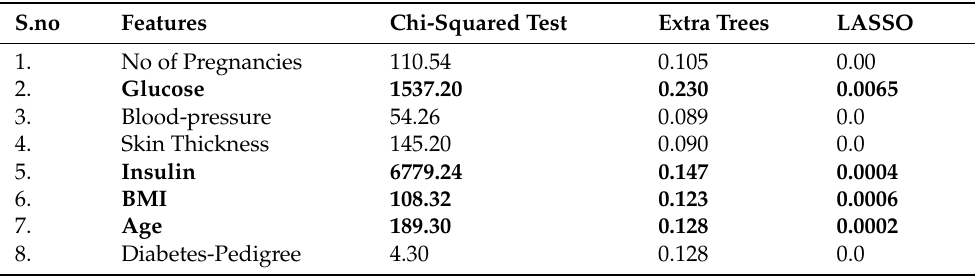
Table 5. PIMA Diabetes real-time